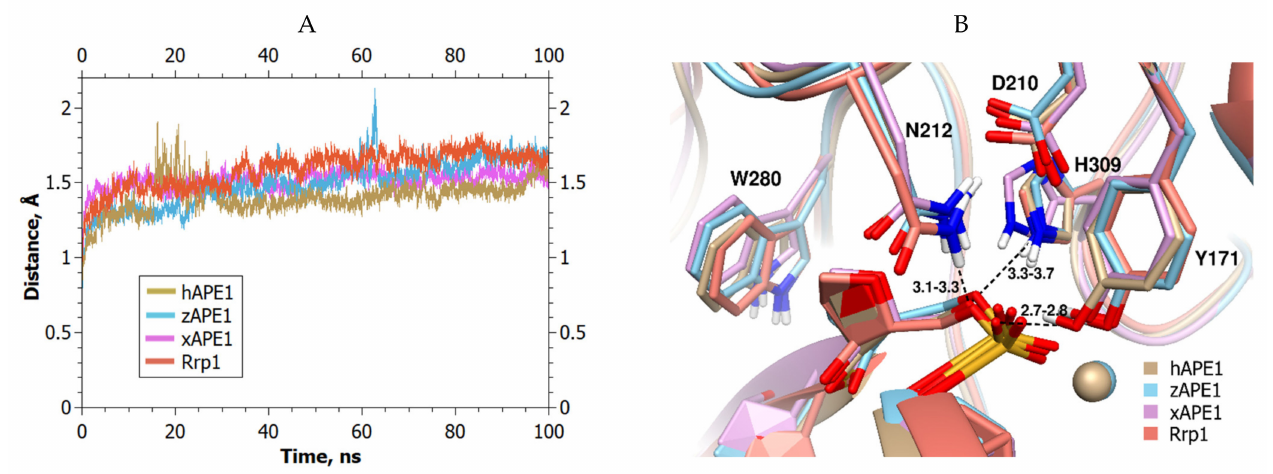
Figure 3. MD trajectories and structures of the complexes of APE1-like endonucleases with abasic DNA: ( A ) Changes in RMSD in the MD trajectories for the analyzed complexes of APE1-like enzymes with DNA containing the F-site; ( B ) structural models of enzyme–substrate complexes (hAPE1 is sand-colored, zAPE1 is cyan, xAPE1 is magenta, and Rrp1 is red). F-site and 5 (cid:48) - phosphate group in the active sites of APE1-like enzymes are shown. The figure also presents ranges of the average lengths (Å) of H-bonds between His309 N ε 2 and O5 (cid:48) , between Asn212 N δ 2 and O5 (cid:48) , and between Tyr171 O η and O2P for different complexes.